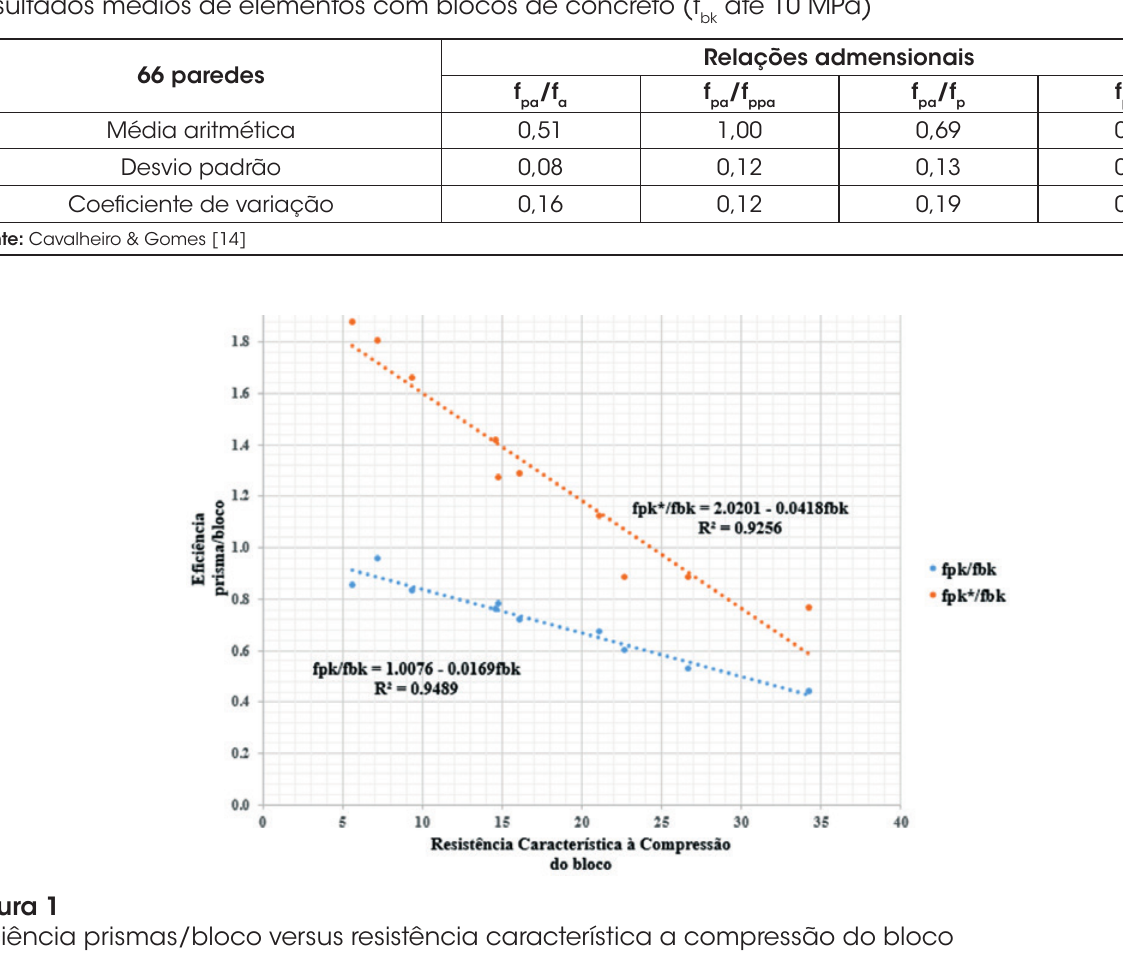
Eficiência prismas/bloco versus resistência característica a compressão do